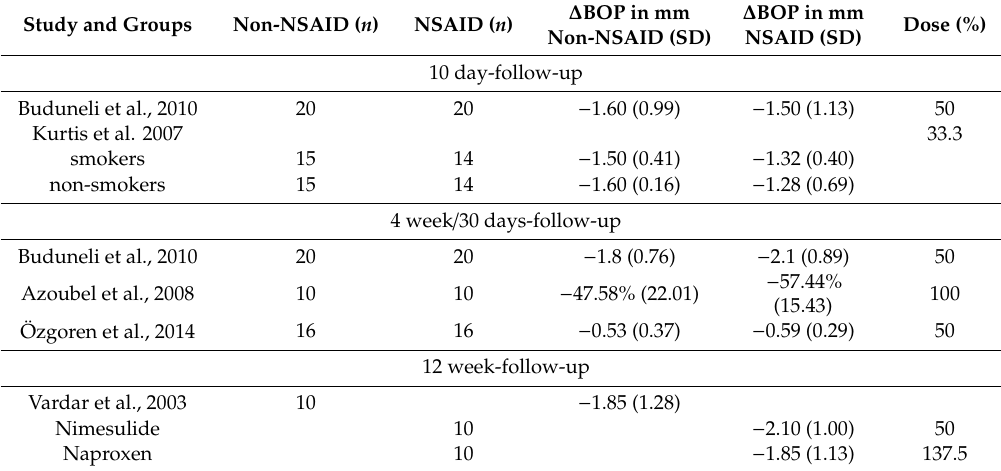
Table 4. Bleeding on probing (BOP) in comparison to non-NSAID and NSAID groups at three di ff erent follow-up